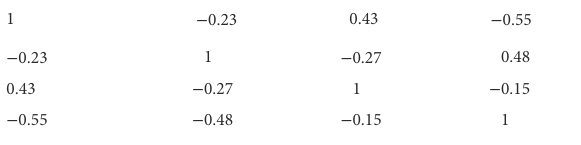
TABLE 6 Correlation coefficient matrix of each